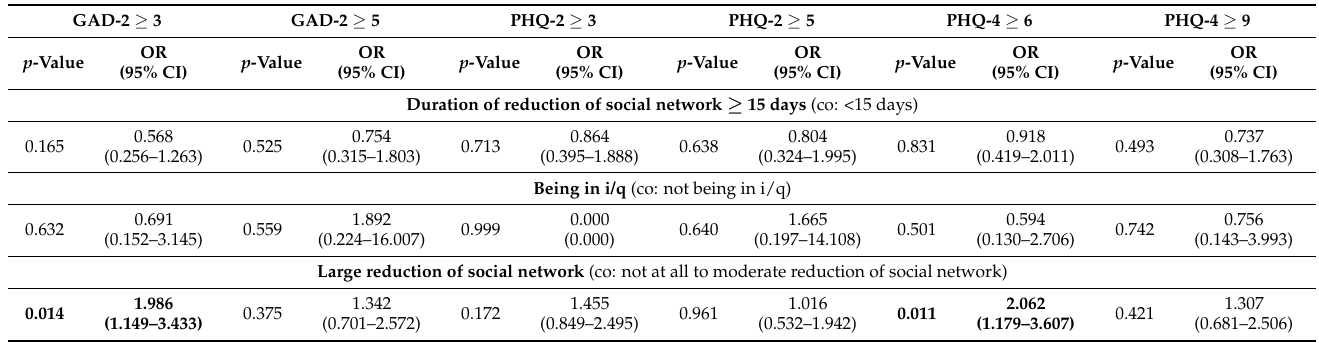
Table 3. Influence of pandemic-specific factors on self-reported mental health outcomes (univariate logistic regression